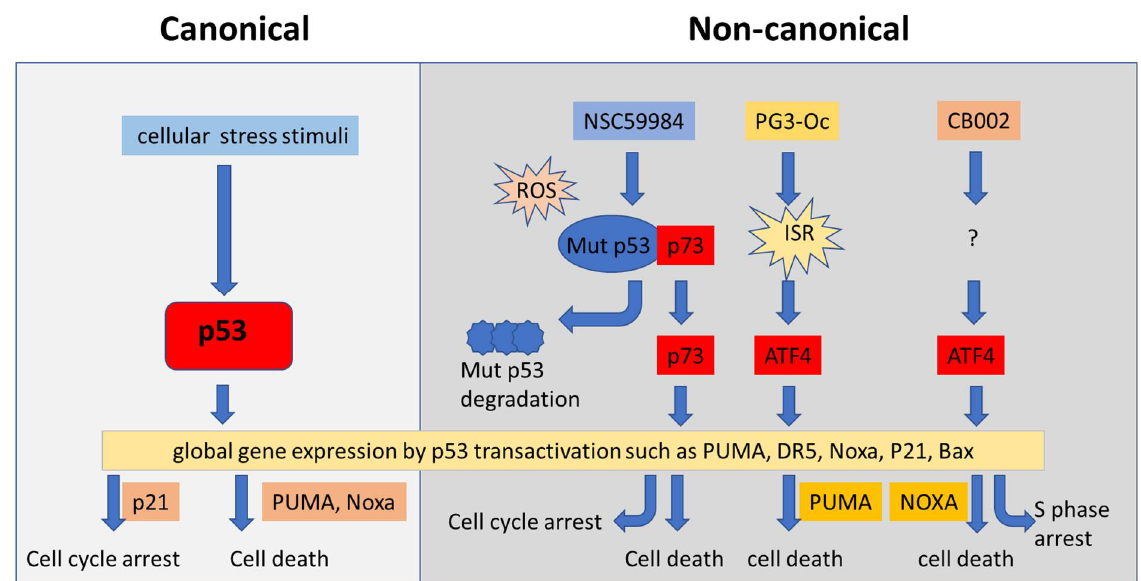
Figure 3. Restoration of p53 pathway signaling in canonical and non-canonical regulatory pathways in cancer cells. Cellular stresses activate p53 pathway signaling through p53 transactivation (canonical pathway, left panel). The p53 pathway signaling is regulated via p73, a p53 family member (such as by NSC59984), or via ATF4 (induction by small molecules such as PG3-Oc and CB002) in mutant p53-expressing cancer cells (non-canonical regulatory pathways, right panel). The gene expression via ATF4 or p73 partially overlaps with the canonical p53 targets, and some of the overlapping canonical p53 pathway signaling target genes (such as Noxa, PUMA, and p21) are crucial for the compounds to induce cell death and cell cycle arrest under different cellular conditions.